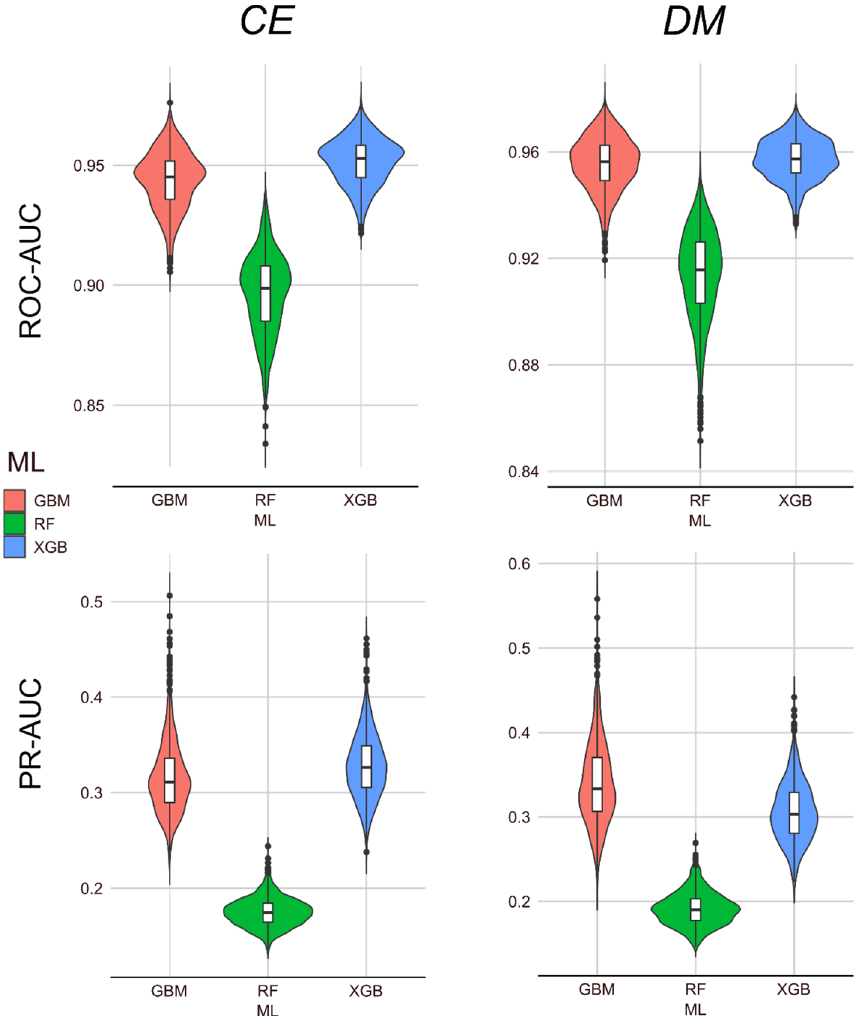
Figure 2. Bootstrap ML approach within species. Violin plots depicting the ROC-AUC and PR-AUC values ( y -axis) for bootstrap approaches for CE ( left ) and DM ( right ) using the 34 best-predictive features identified for these species. A total of 1000 random selections containing 90% of the genes (essential and non-essential) were used to train the gradient boosting machine (GBM), random forest (RF), and eXtreme gradient boosting (XGB) models ( x -axis), using the remaining 10% of the genes for testing.